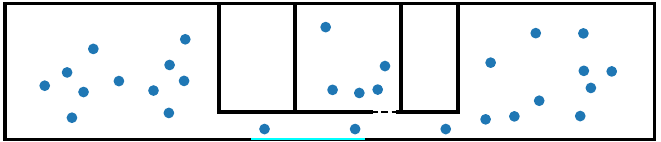
Figure 9. Measurement points distribution of static RSSI